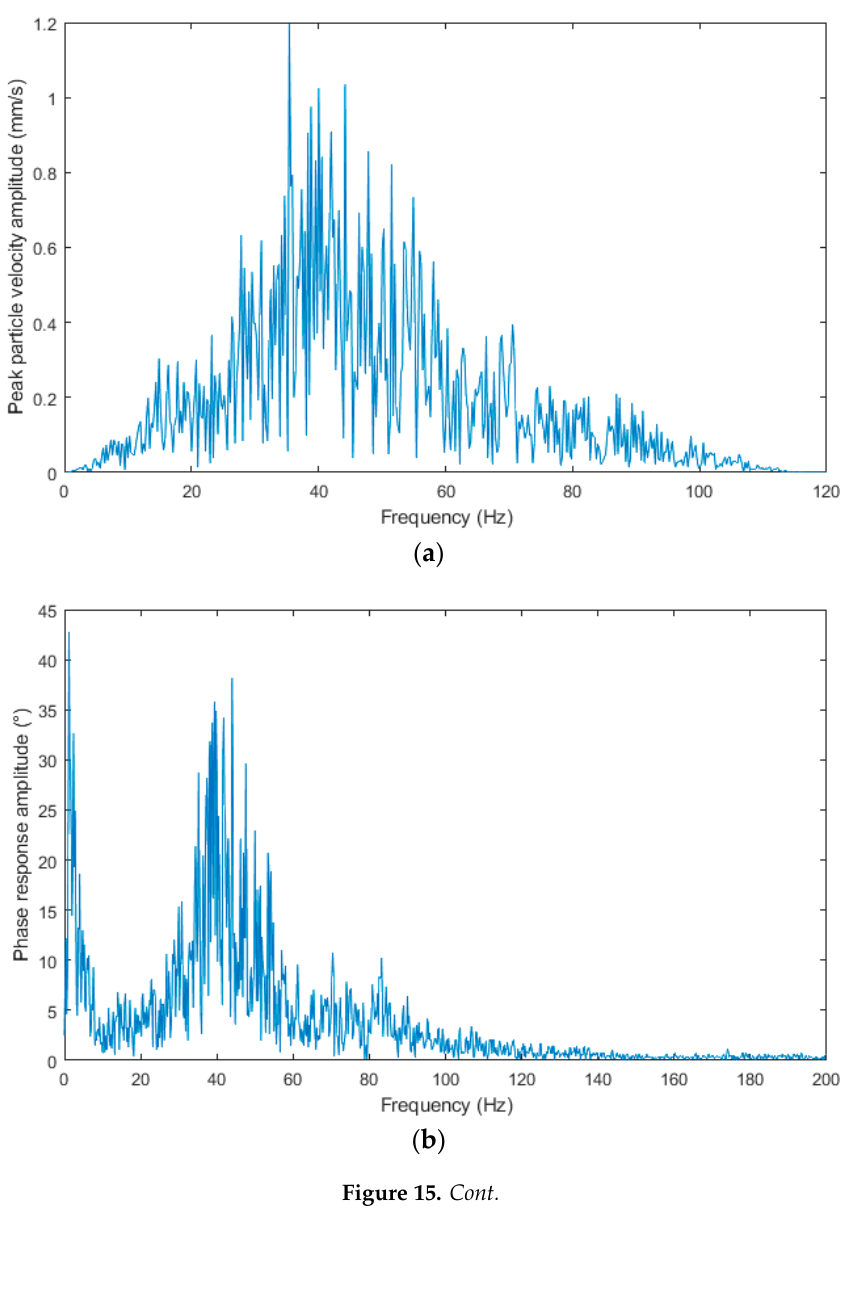
Figure 14. The waveform images from the blasting operation recording of April 26, 2019: ( a ) Seismic apparatus BRS32; ( b ) interferometric sensor; ( c ) acoustic sensor; ( d ) graphical comparison of the three records described above in one graph.